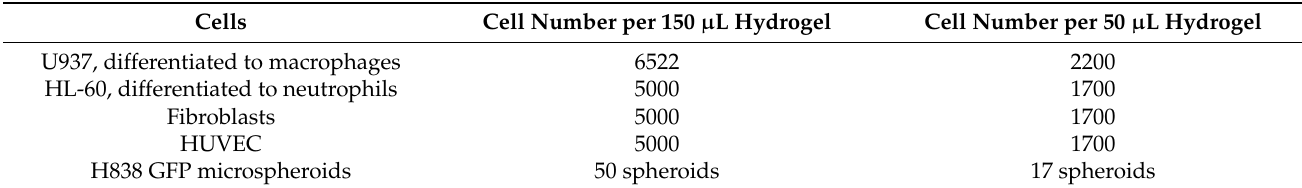
Table 2. Cells used for the preparation of the 3D tumor-stroma model. Total volume 150 or 50 µ L.